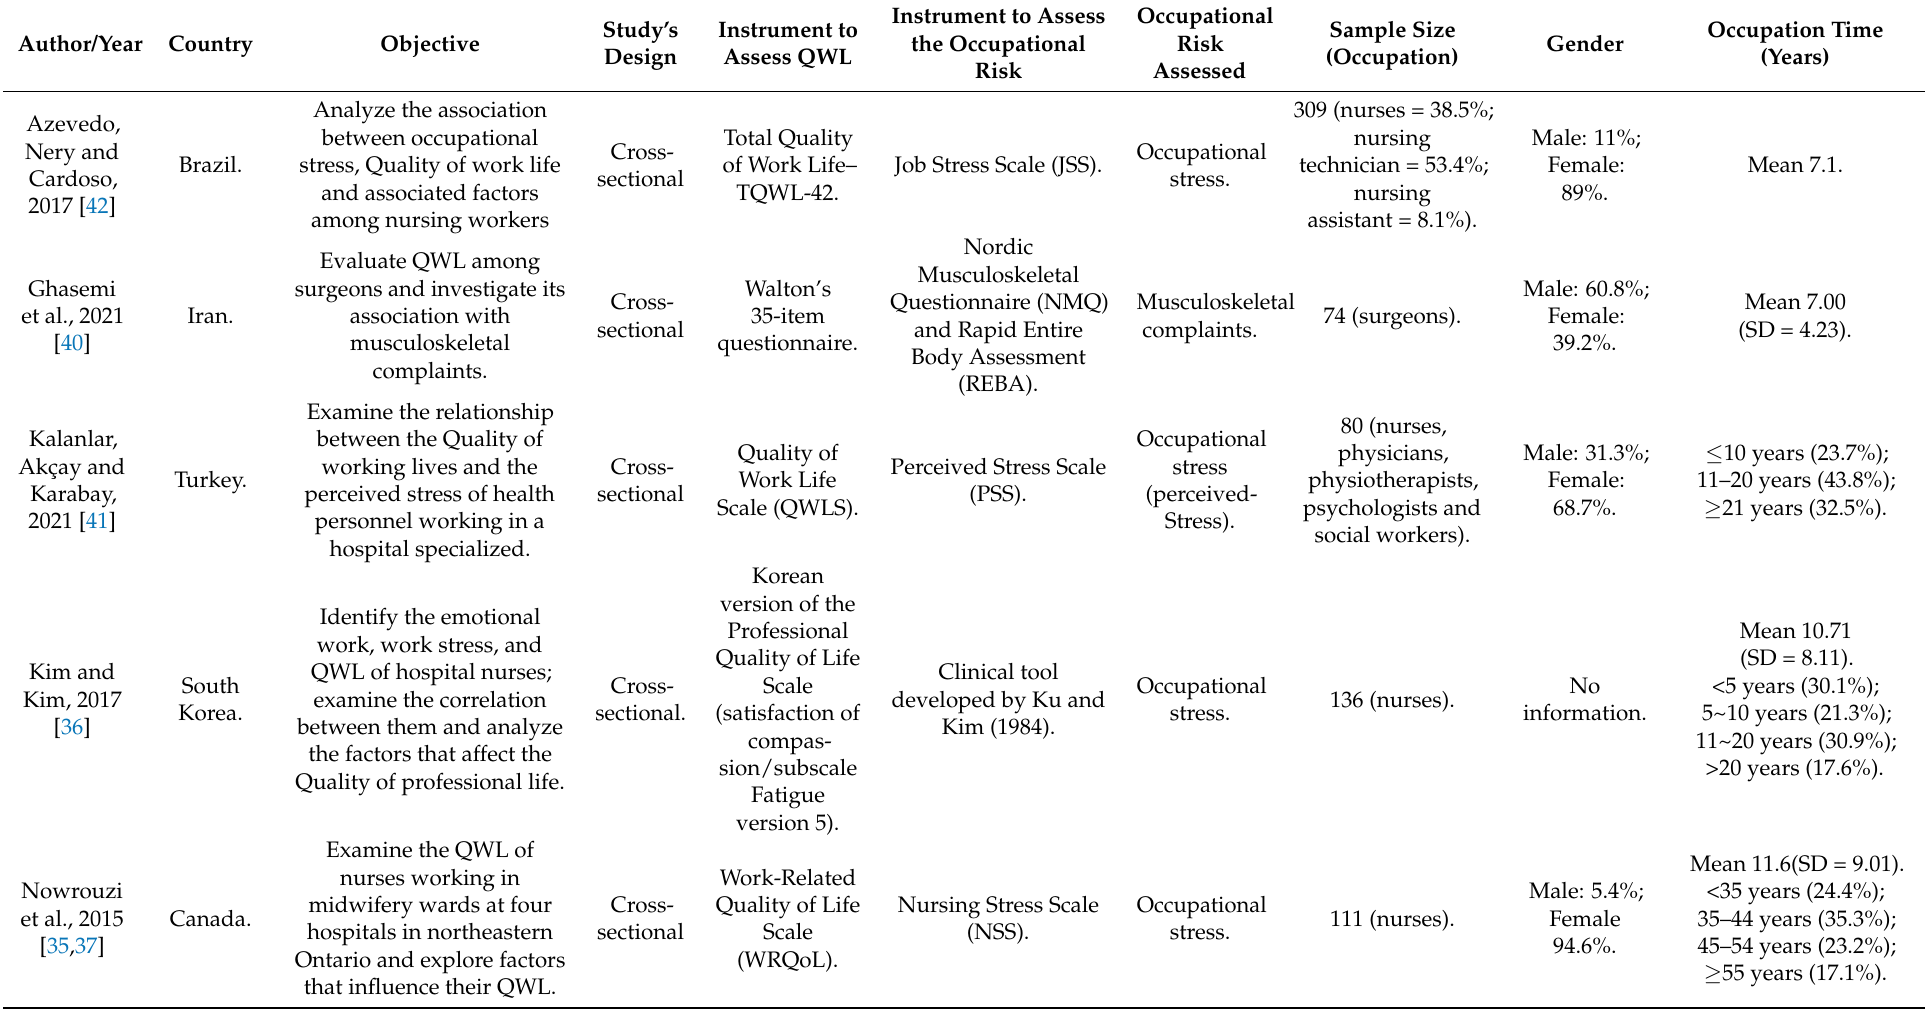
Table 2. Summary of the findings in the documents included in the review regarding quality of work life